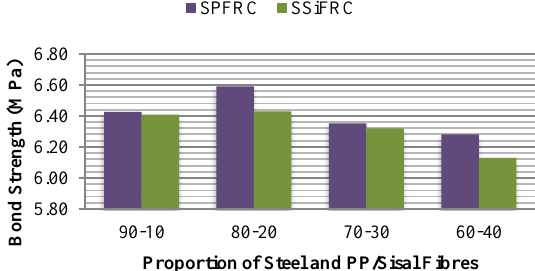
Figure 4. Performance of HyFRC at 28 days